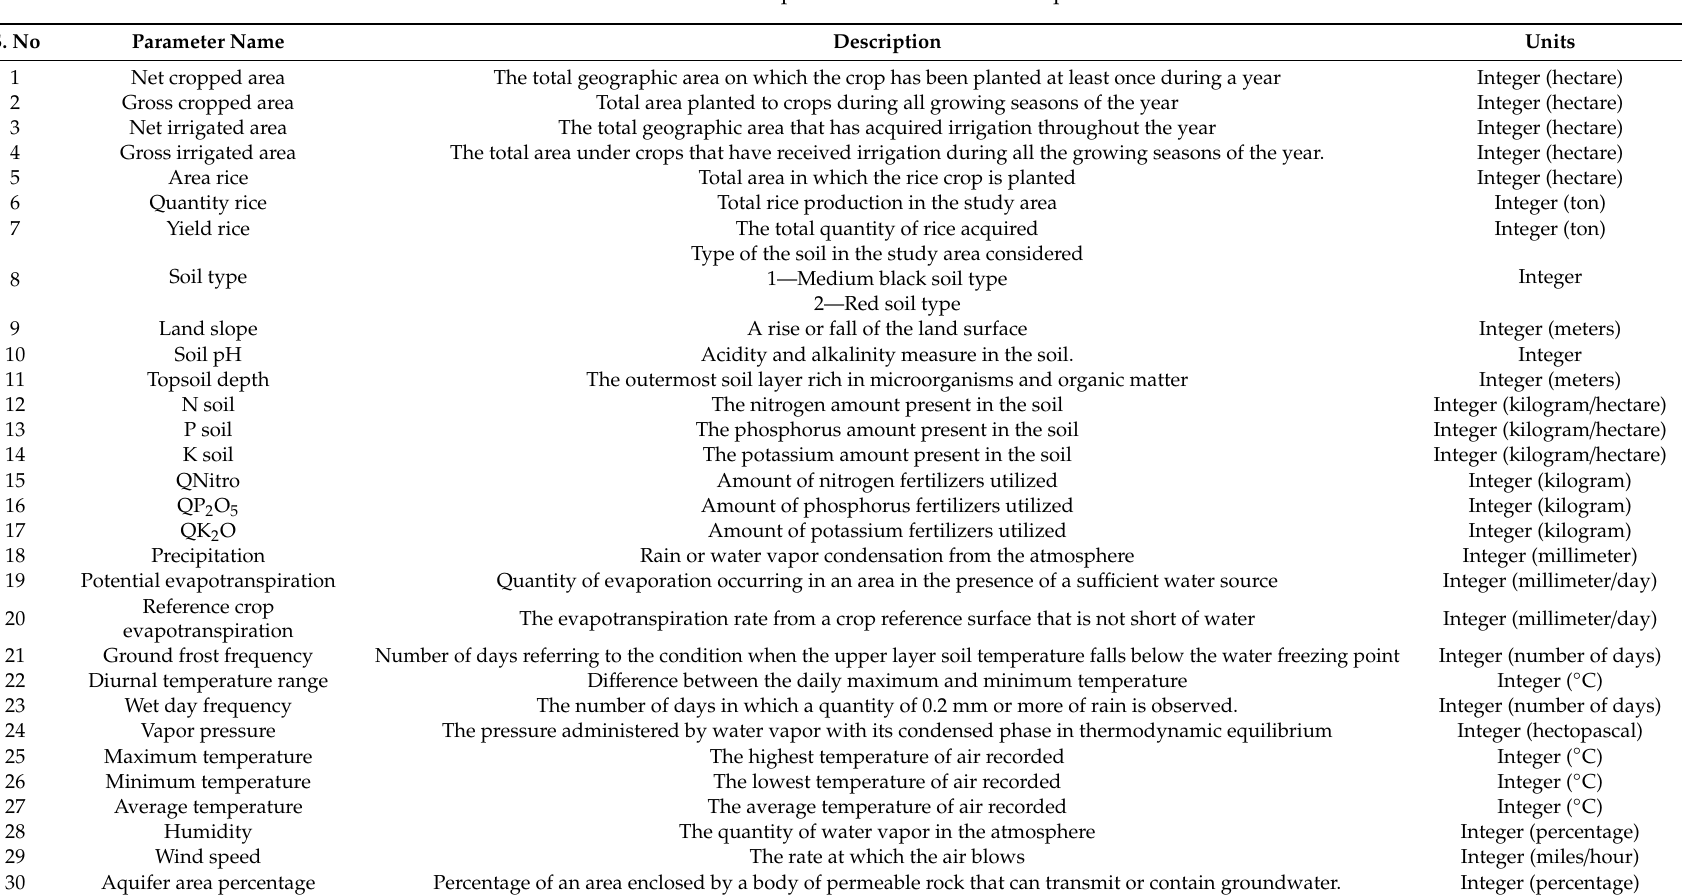
Table 1. List of dataset parameters and their